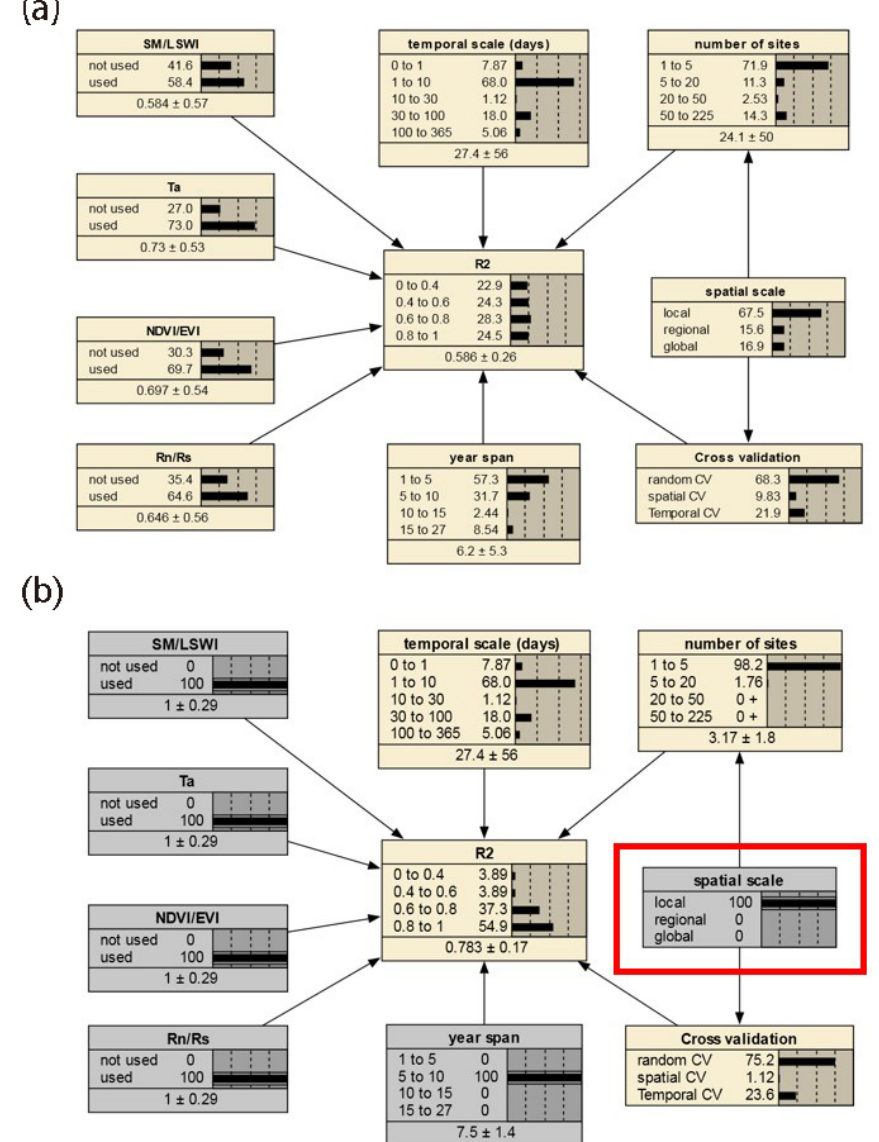
Figure 9. The joint effects of multiple features on R 2 based on the BN with all records input (a) and the inference on the probability distribution of R 2 based on the BN with the status of some nodes determined (b) . The values before and after the “ ± ” indicate the mean and standard deviation of the distribution, respectively. The gray boxes indicate that the status of the nodes has been determined. In (b) , specific values of parent nodes such as “spatial scale” are determined (shown in the red box), leading to an increase in the expected R 2 compared to the average scenario of (a) (as inferred from the posterior conditional probabilities with the status of the node spatial scale determined as